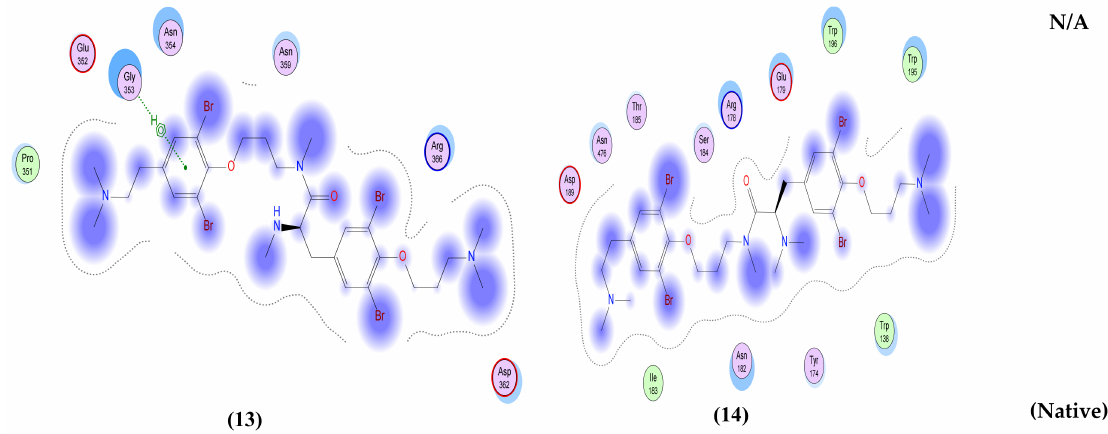
Figure 7. The 2D interactions between the 14 library compounds and the native ligand with membrane glycoprotein (PDB ID: 6M17).